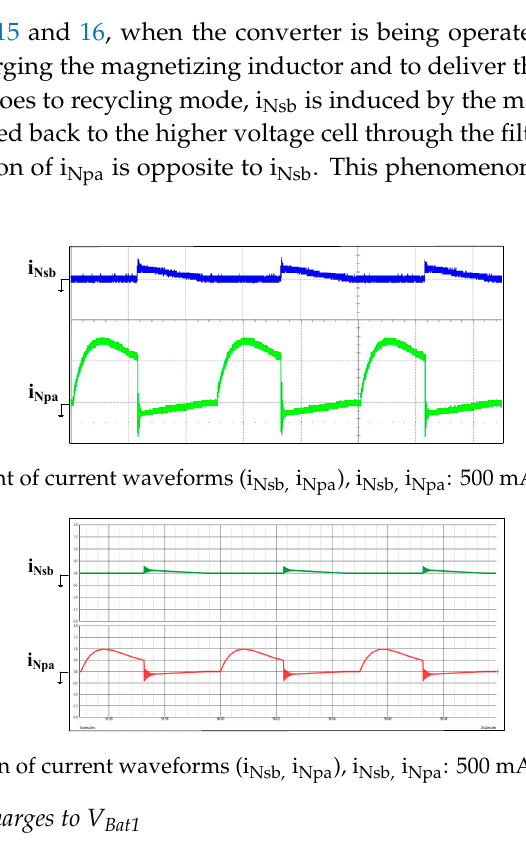
Figure 14. Simulation of voltage waveforms of S a (V GSa , V DSa ), V GSa , V DSa : 10 V/div, Time: 20 µs/div.